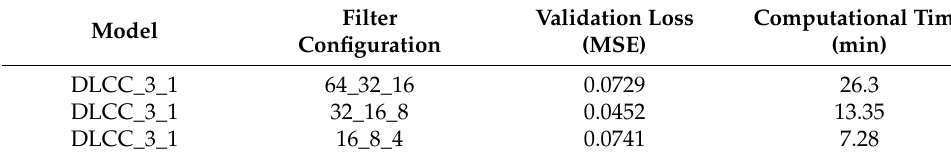
Table 3. Comparison of the different filter configuration of